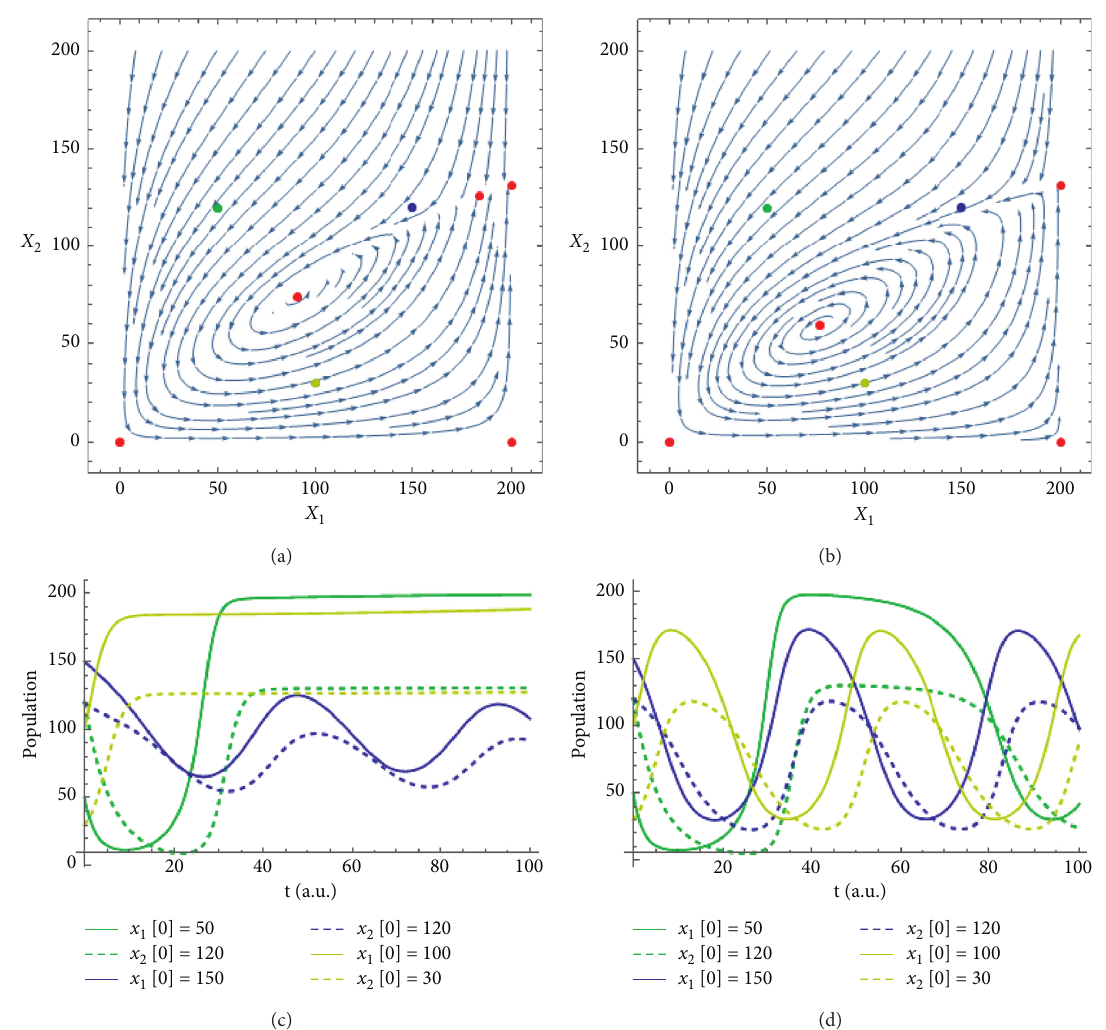
Figure 5: Phase space and trajectories for two populations involved in a predator-prey interaction. We show here a special case where the coexistence spiral solution diverges and become unstable. When that happens, a limit cycle appears. To the left, we have a case with a smaller � − 0 . 006435 than to the right, where b � − 0 . 0072. In both cases, b � b � 0 . 0036, which means that both populations predation, i.e., b 12 12 11 21 benefit the same from population X , but the predatory effects of X on X are stronger on the right. For greater cooperation values, the 1 2 1 intermediate solution might even disappear, as it is shown on the right. The green, blue, and yellow dots in the phase space mark the initial � 0 . 15 and r � − 0 . conditions of the simulations located below. Here, r 1 2